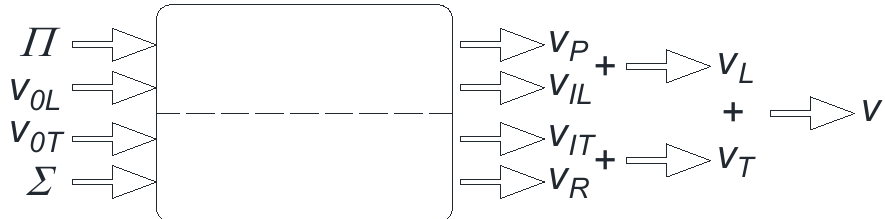
Figure 13. TULF model component-wise block diagram of detailed velocity field decomposition.